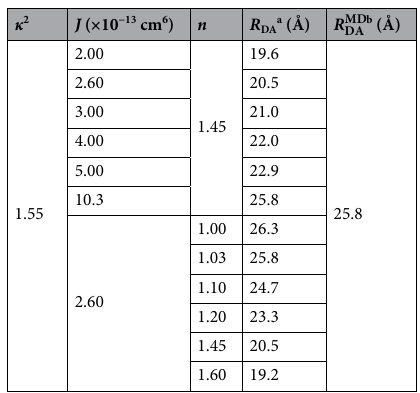
Table 2. Effect of spectral overlap ( J ) and refractive index ( n ) on intermolecular distance ( R DA ). a Intermolecular distance determined by Eq. (4). b Average of intermolecular distances obtained from a 100–130 ns MD